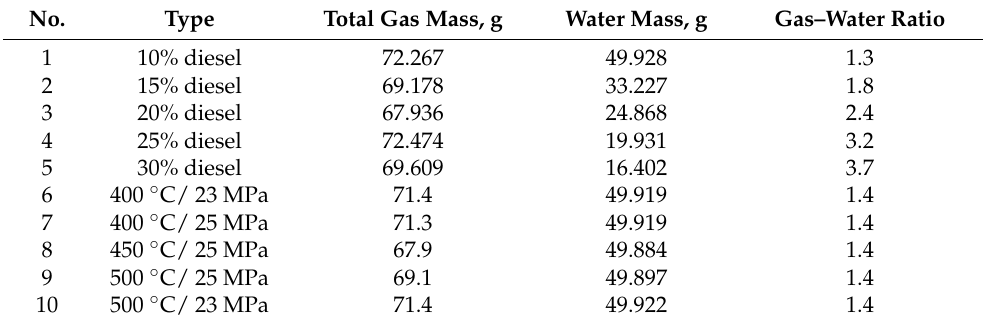
Table 13. Gas–water mass ratio of supercritical multi-thermal fluid generated by supercritical water– diesel reaction under different